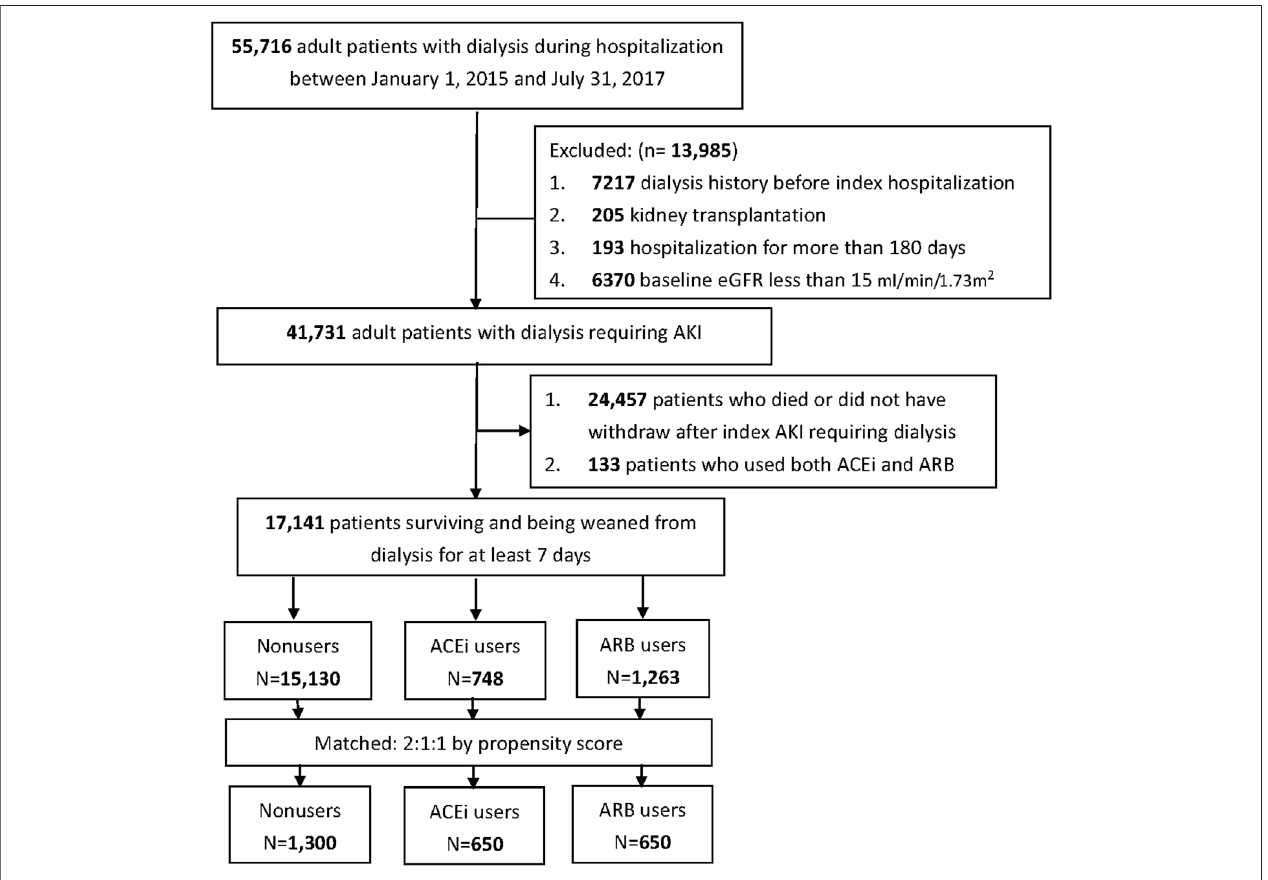
FIGURE 1 | Flow diagram of the